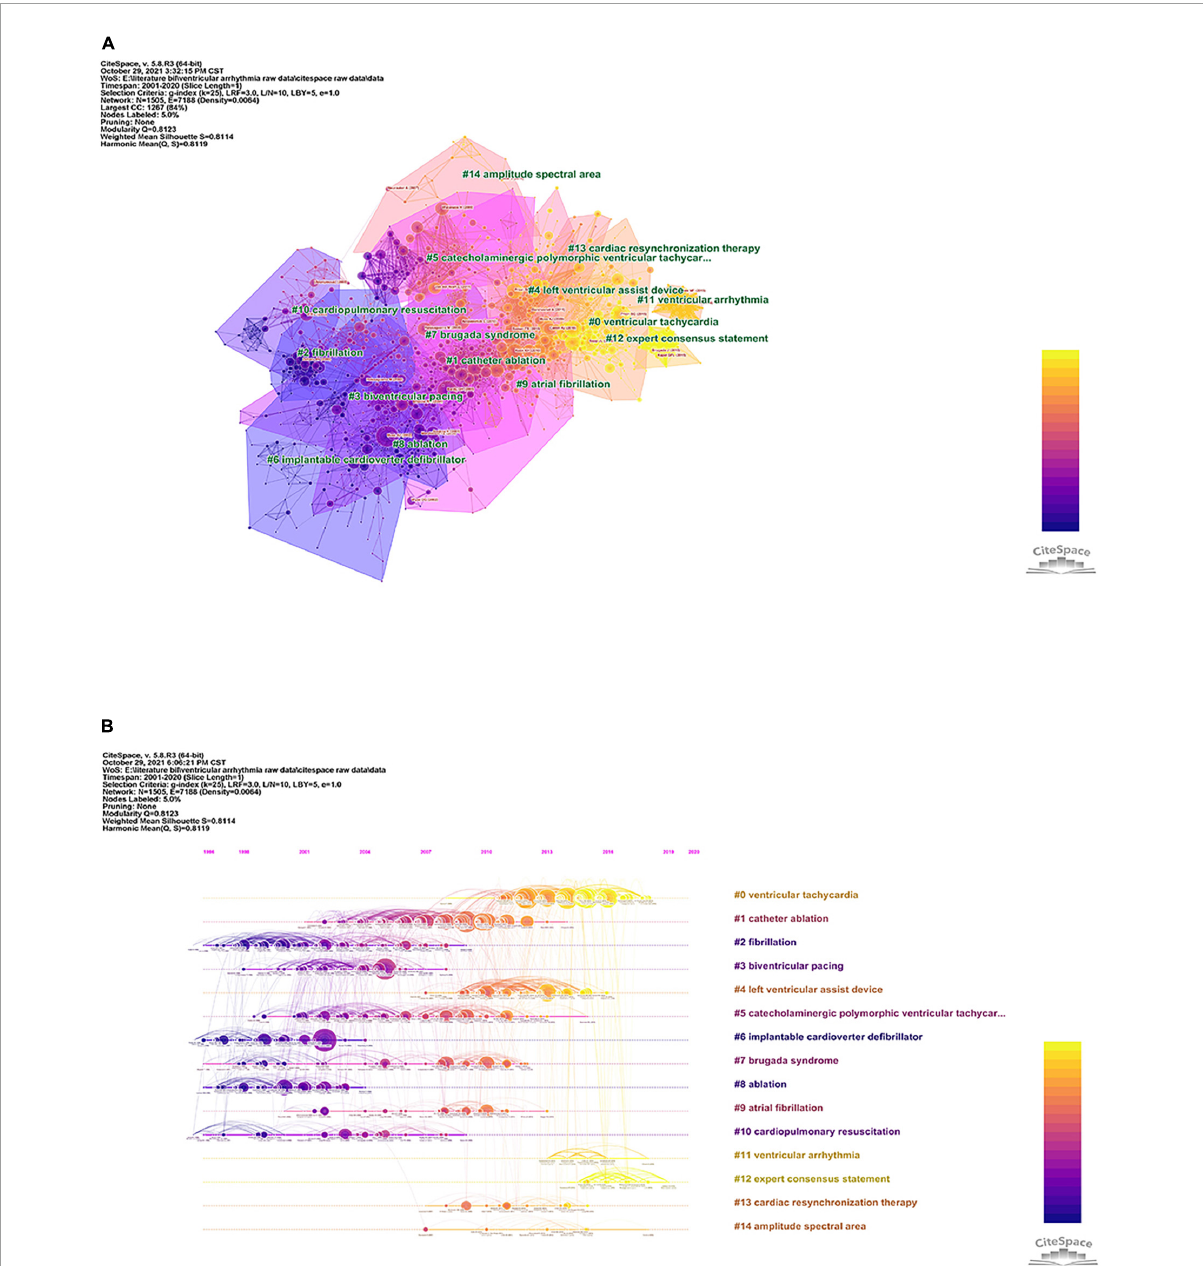
FIGURE6 References’ co-citation and cluster analysis. Network map of co-cited references on ventricular arrhythmia research (A) and the timeline view with corresponding cluster labels on the right side (B)